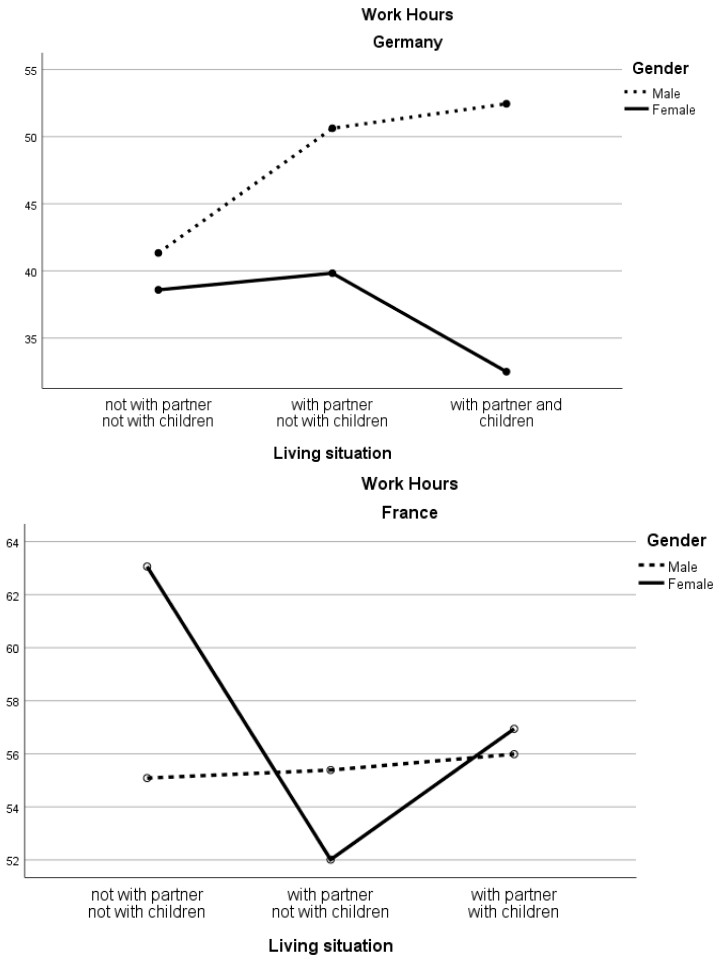
Figure 1. Three-way interaction between gender, country and home for working hours.